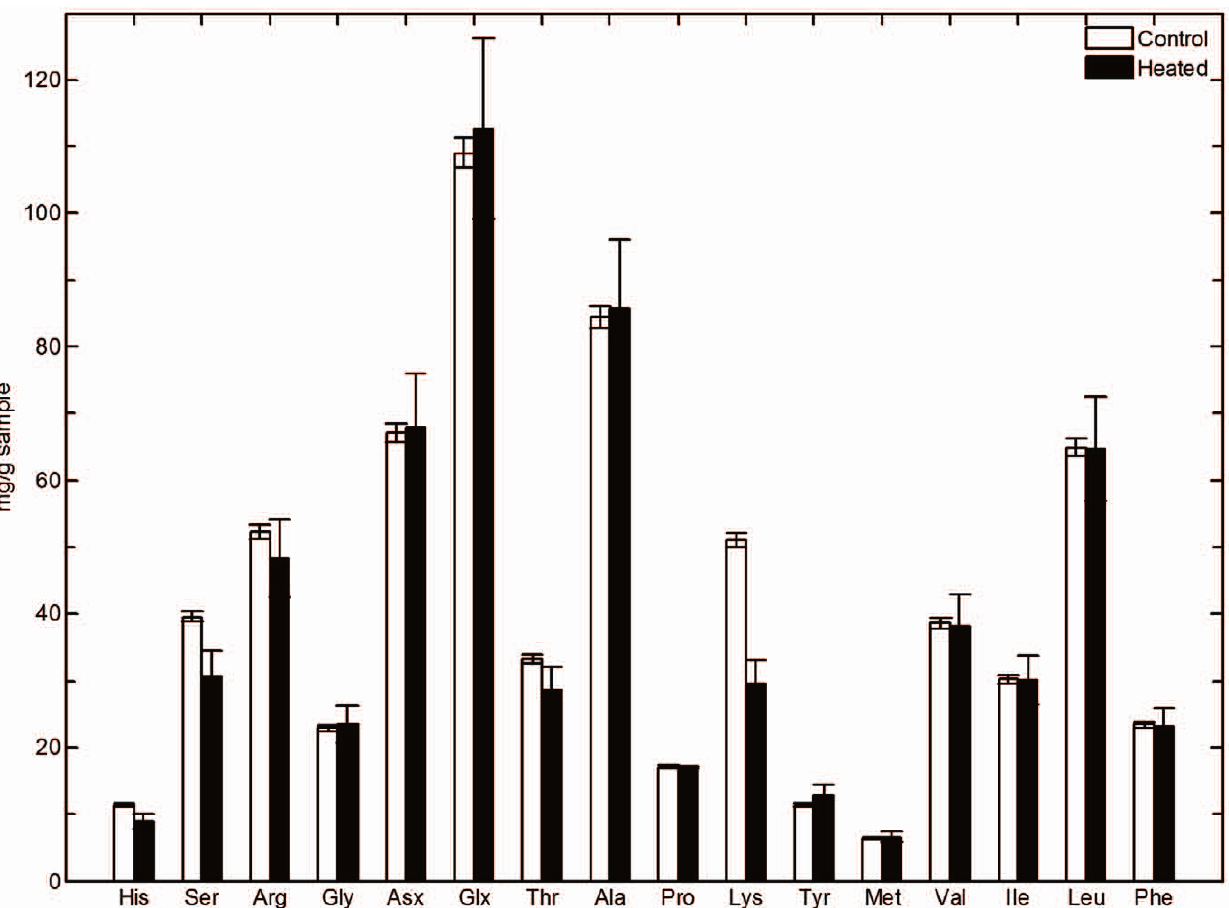
Figure 6. Amino acid analysis results obtained by acid hydrolysis, comparing a control untreated honeybee silk sponge sample to a sponge sample heat treated at 190 6 C for 60 minutes. Error bars represent one standard